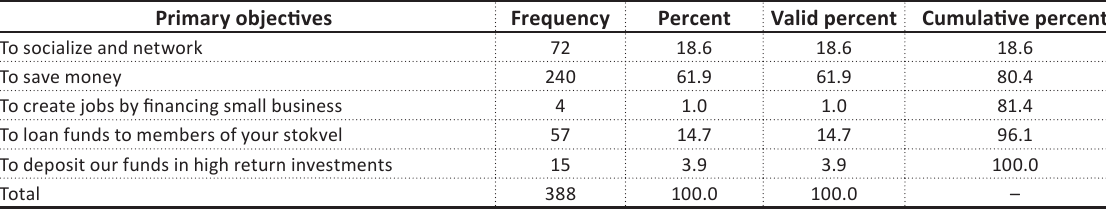
Table 6. Response on primary objectives of stokvels